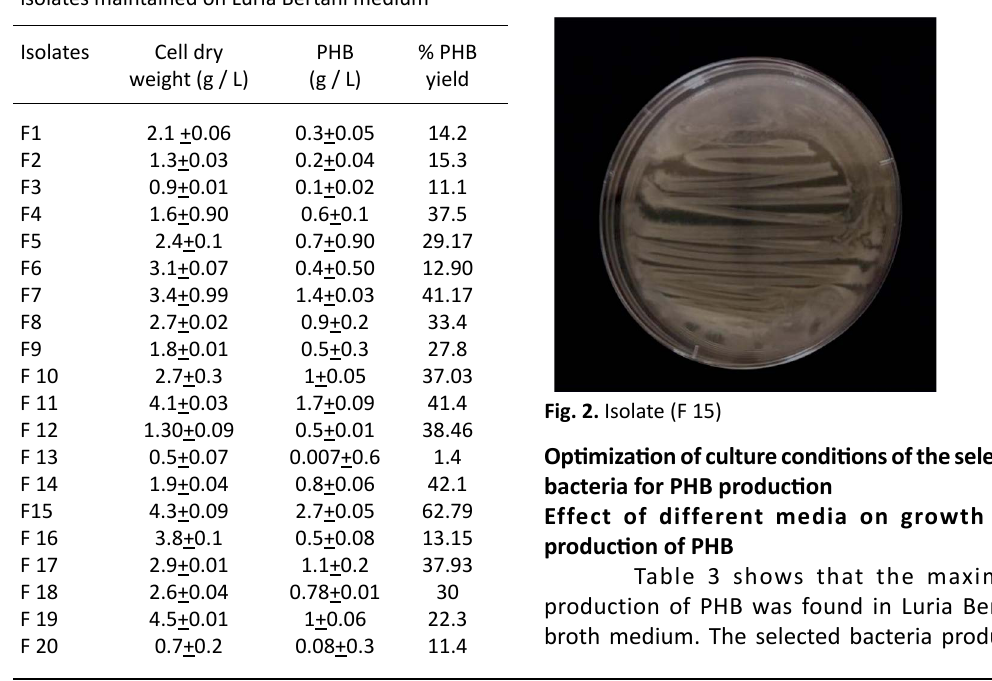
Fig. 1. Colored gunnels staining by Sudan black identified by staining them with Sudan black and measuring the fluorescence intensity to detect them. Isolate (F15) was the best in production of PHB. This isolate was grown in a production medium for further examination. Identification of bacteria Identification of the best isolate in production of PHB was done by studying it’s morphological, cultural characterizations table 2, Fig. 2. The Identification was based on Gram stain, spore test, motility, and several physiological and biochemical tests described by (“Bergey’s Manual of Determinative Bacteriology” 9th ed., 1994).